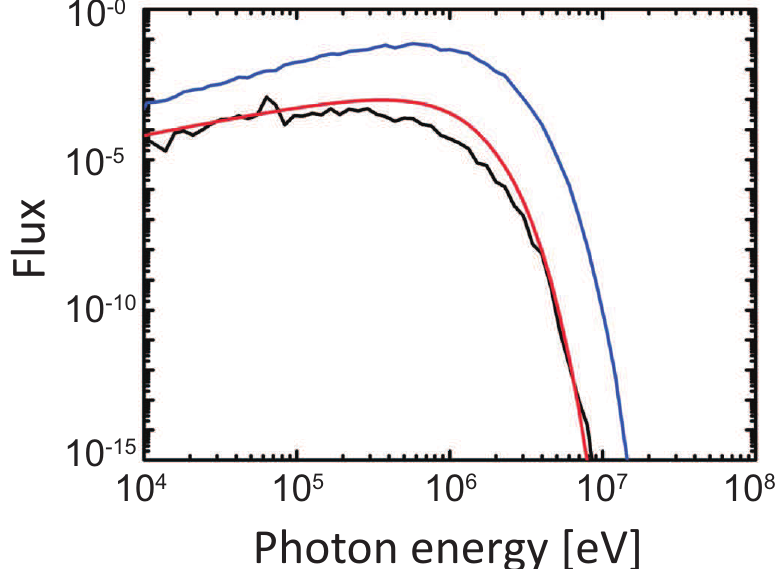
Figure 2. The calculated energy spectrum of the γ -rays generated by the bremsstrahlung on the solid gold target. The photon flux suddenly decreases above 1 MeV. The blue line indicates the energy spectrum of the primary electron pulse with energy of kT = 300 keV. The red line shows the Planck distribution with energy of kT = 225 keV. The bremsstrahlung spectrum can be reproduced by the Planck